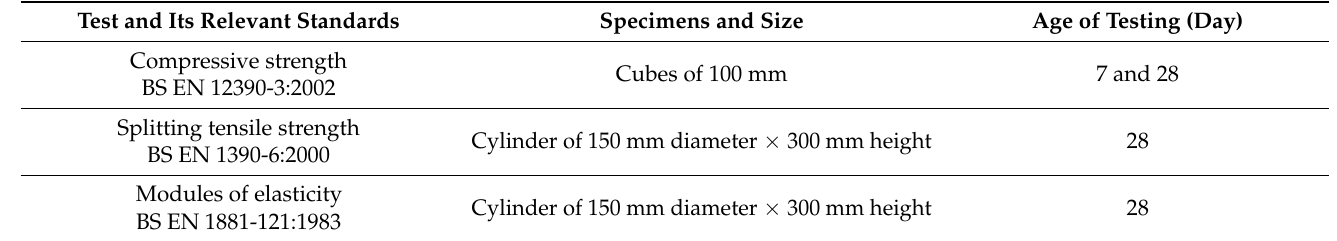
Table 5. Pertinent standards for examining the mechanical properties of concrete.